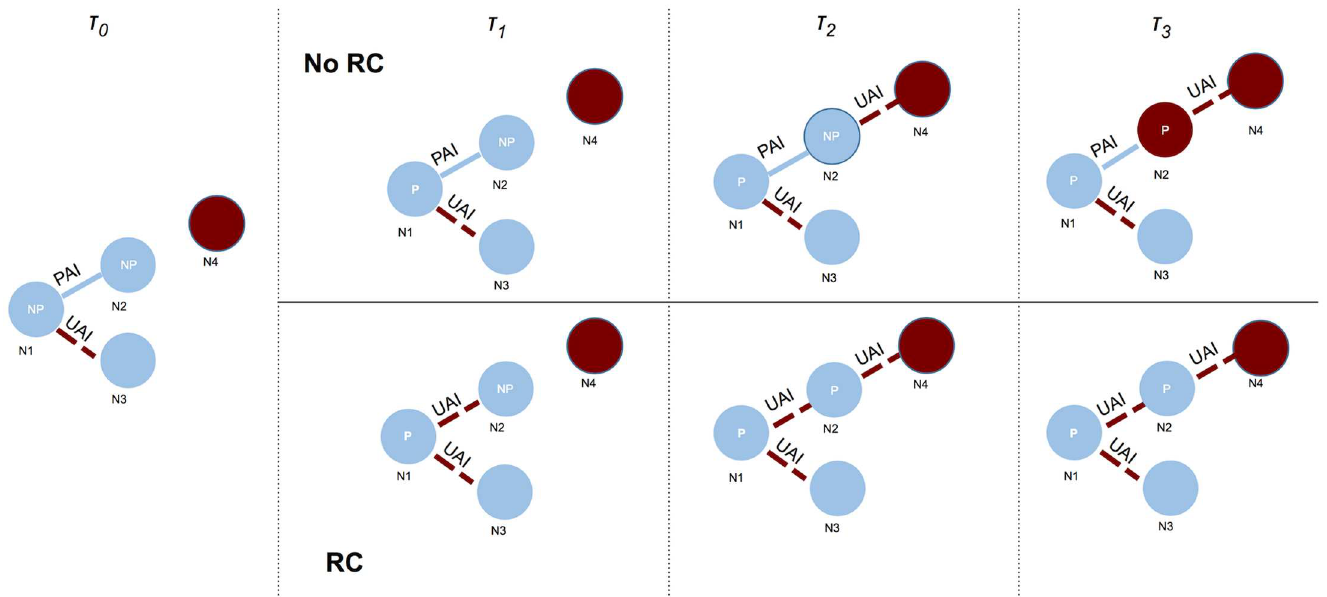
Fig 3. Schematic diagram showing the feedback loop between increased risk compensation, higher behavioral indications, and PrEP uptake among a four-person network over four time steps. At t0 , Node 1 (N1) engagesin condom unprotectedanal intercourse (UAI) outsideof a monogamous partnership(with N2 and N3), which leads to his indicationsfor and uptake of PrEP at t1 . In the risk compensation (RC) scenario,PrEP is associated with an increasein UAI (with N2), a PrEP non-user, whereasin the counterfactual no RC scenario,behaviorremainsthe same as protected anal intercourse (PAI). At t2 , N2 has engagedin UAI with N1 in the RC scenario, becomesindicatedfor PrEP, and uses it before initiatingUAI with N4, an HIV-infected (status unknown) partner. In the No RC scenario, the PrEP uptake is delayeduntil t3 , but N2 has already become infected by